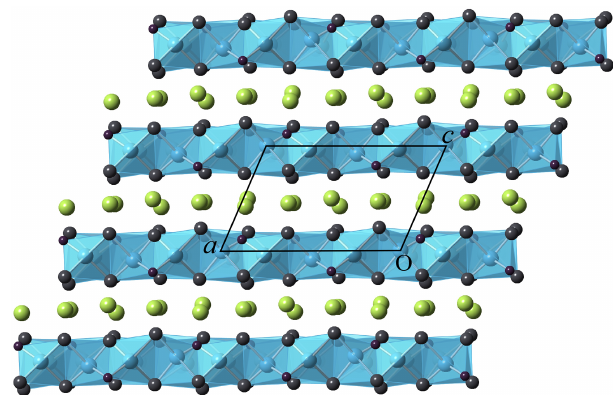
Figure 2. Crystal structure of heliophyllite as seen along [010]. Layers formed by edge-sharing oxocentered OPb 4 (cyan) regularly alternate with layers hosting Cl atoms (yellow). Table 4. Fractional atomic coordinates and equivalent isotropic dis- placement parameters (Å 2 ) for heliophyllite. According to EPMA chemical composition, a common occupancy for As1 and As2 sites was fixed to As0.97, together with a common occupancy for split Sb1 and Sb2 sites of